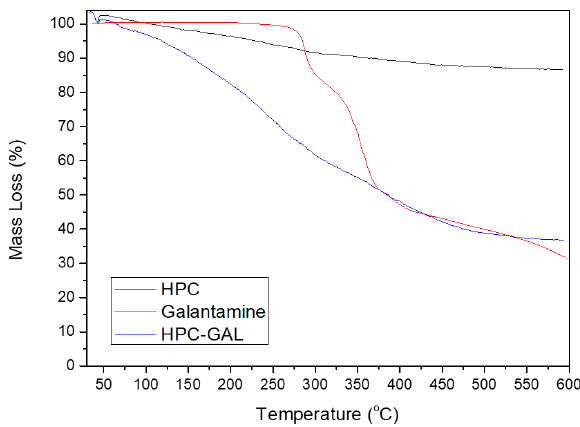
Figure 2. TGA curves of HPC and galantamine before and after its adsorption.